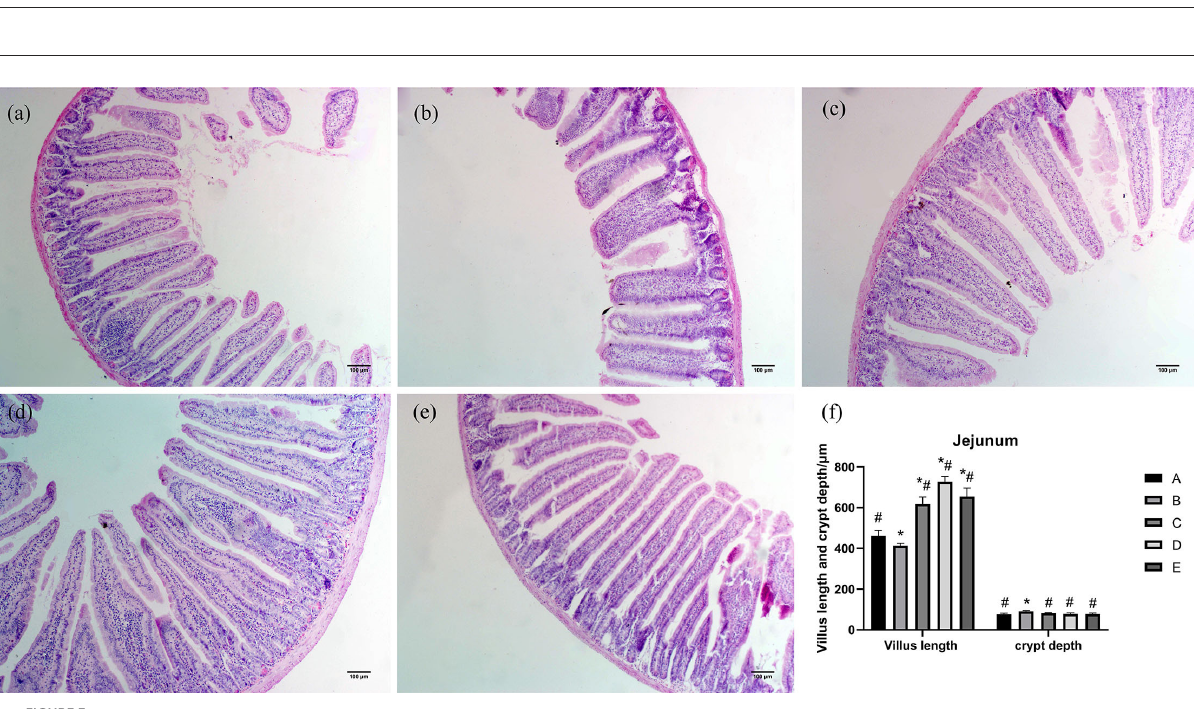
FIGURE3 Effects of CSPCM on the morphological features of the ileum. (a) Morphological observation of ileum in group A. (b) Morphological observation of ileum in group B. (c) Morphological observation of ileum in group C. (d) Morphological observation of ileum in group D. (e) Morphological observation of ileum in group E. (f) Effect of CSPCM on ileum villus length and crypt depth. * Significant difference with group A ( P < 0.05). # Significant difference with group B ( P <